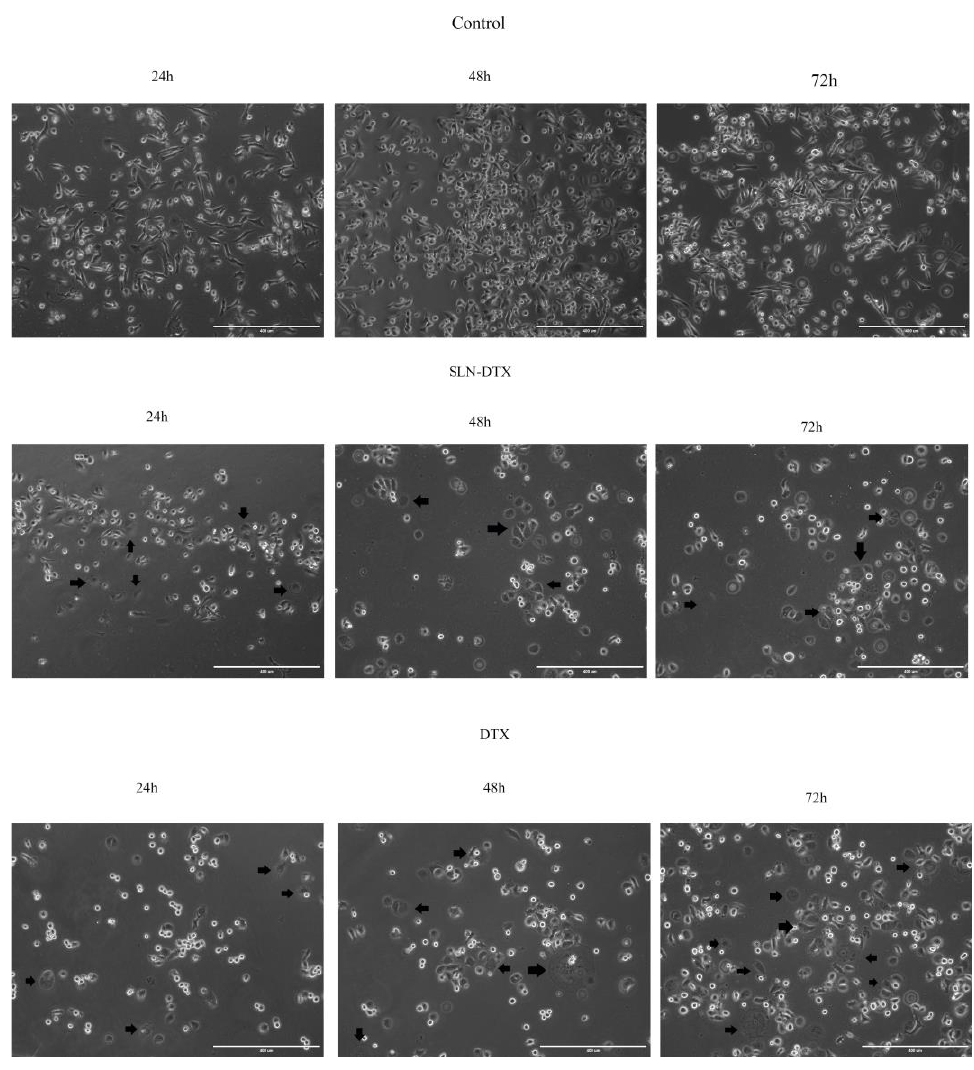
Figure 2. Morphological evaluation of MDA-MB-231 cells at 24 h, 48 h, and 72 h after control and treatment with SLN-DTX and DTX by light microscopy. Arrows indicate treated cells that show changes in the cytoplasm. Scale bar 400 μm.